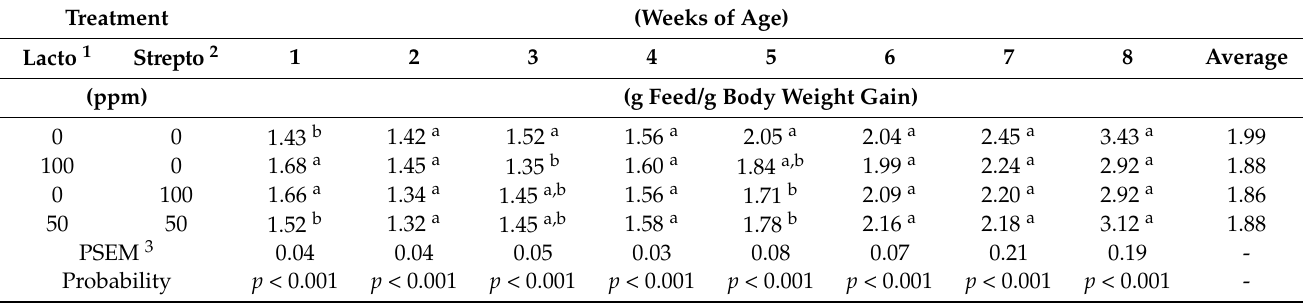
Cumulative BWG at 5–8 WOA of the broiler chickens fed the diets containing either L. reuteri or S. coelicolor were significantly lower ( p < 0.05) that those of birds fed the control diet (11–12%) and those fed the combination of L. reuteri and S. coelicolor (1:1, 50 ppm) by about 8–9%. However, the reduction if BWG of birds fed the combination of L. reuteri and S. coelicolor was only 2% when compared to the control. Therefore, L. reuteri and the combination of L. reuteri and S. coelicolor improved BWG of broilers at hatch to 4 WOA, but not at 5–8 WOA. The synergistic effect of the L. reuteri and S. coelicolor seem to ameliorate the depression of BWG observed in feeding 100 ppm of either L. reuteri or S. coelicolor. The mean feed conversion ratio (FCR) of broiler chickens fed probiotics from hatch to 8 WOA are shown in Table 4. At 1 WOA, birds fed diets containing either L. reuteri or S. coelicolor exhibited a higher FCR than birds fed the control diet and those fed the combination of L. reuteri and S. coelicolor ( p < 0.05). Differences in FCR between birds fed the control diets and those fed the combined L. reuteri and S. coelicolor were not significant ( p > 0.05). Average FCR of broilers fed diets containing the combined L. reuteri and S. Coelicolor during week 1–4 was 22% lower ( p < 0.05) than that of broilers fed the control diet. The average FCR of birds fed either the L. reuteri or S. coelicolor was not different from the control. The average FCR of week 5–8 was 11, 12, and 8% lower in broilers fed diets containing the L. reuteri, S. coelicolor, and combination of L. reuteri and S. coelicolor, respectively, when compared with the control. On the other hand, the FCR of birds fed either the L. reuteri or S. coelicolor was 4% lower than that of birds fed the L. reuteri and S. coelicolor combined. Table 4. Feed Conversion ratios of chickens fed different probiotics from hatch to 8 weeks of age. Treatment (Weeks of Age)